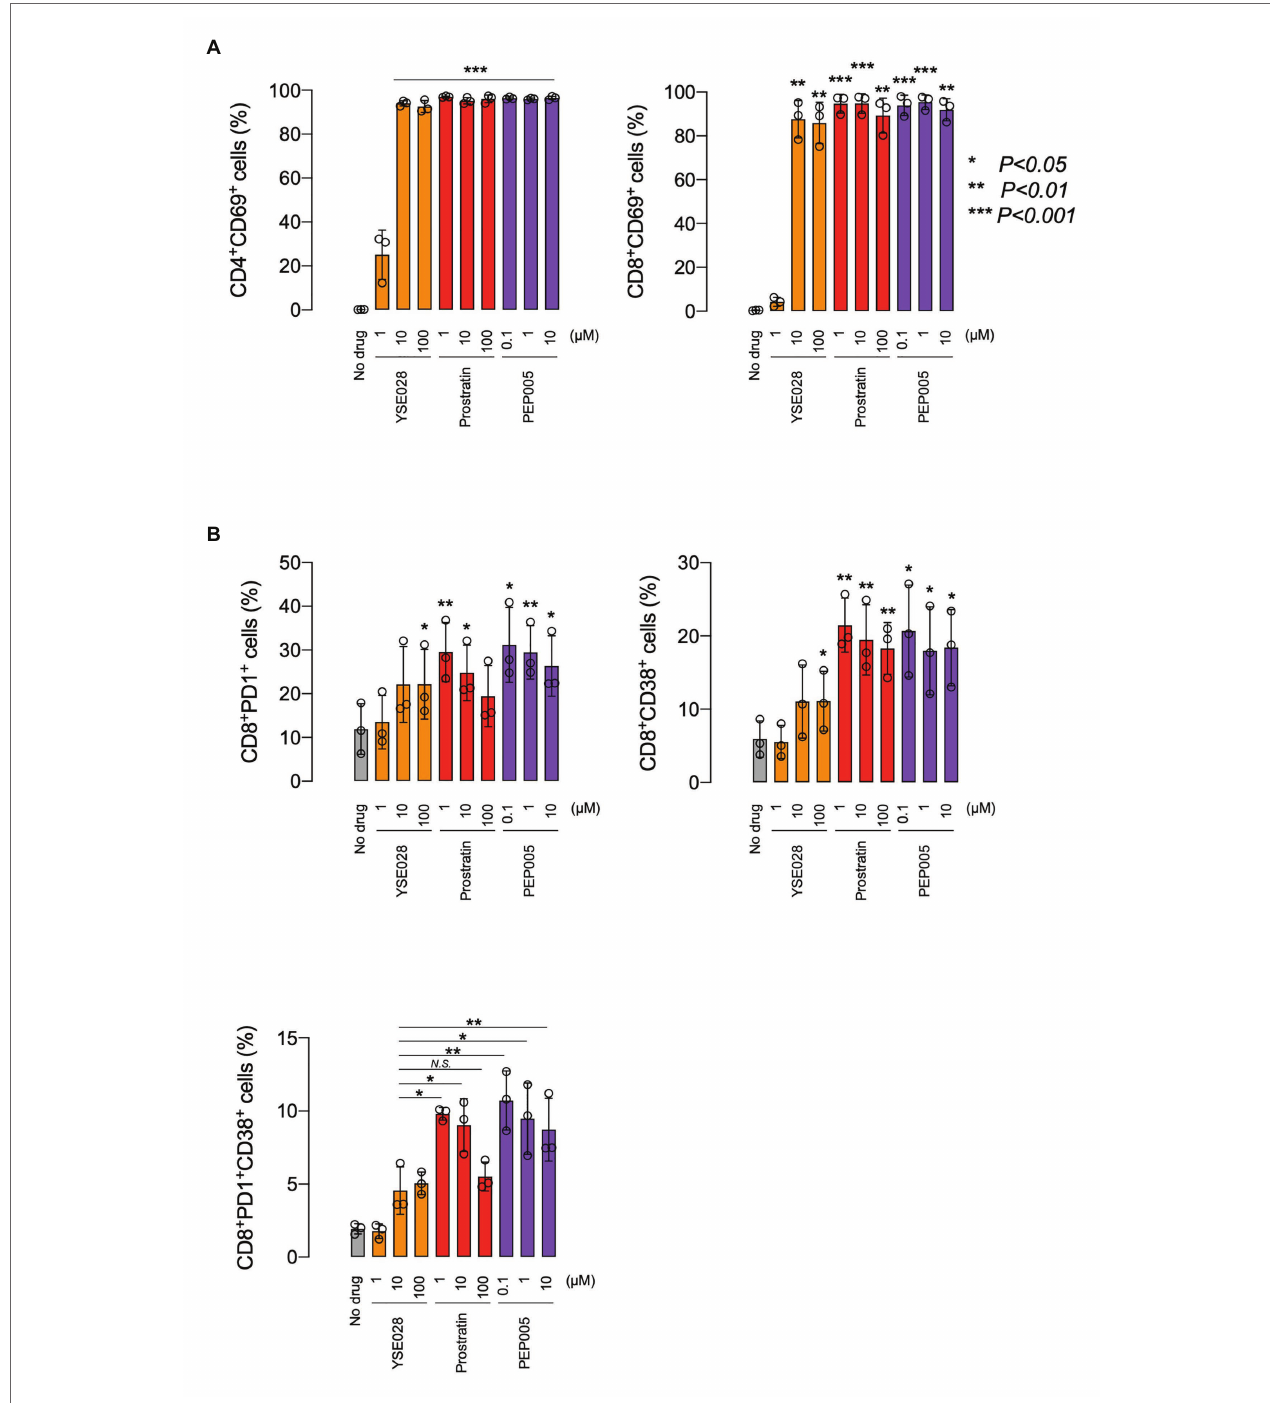
FIGURE 5 | The effect of YSE028 on T cell activation. PBMCs from three healthy donors were exposed to different concentrations of a reagent for 24 h. Changes in CD69 expression on CD4 + or CD8 + primary T cells (A) , CD8 + PD1 + primary T cells, CD8 + CD38 + primary T cells, and CD8 + PD1 + CD38 + primary T cells (B) were analyzed by flow cytometry. Data are shown as means ± SDs. Statistical significance was determined using a paired T-test, where a value of p < 0.05 was considered to be